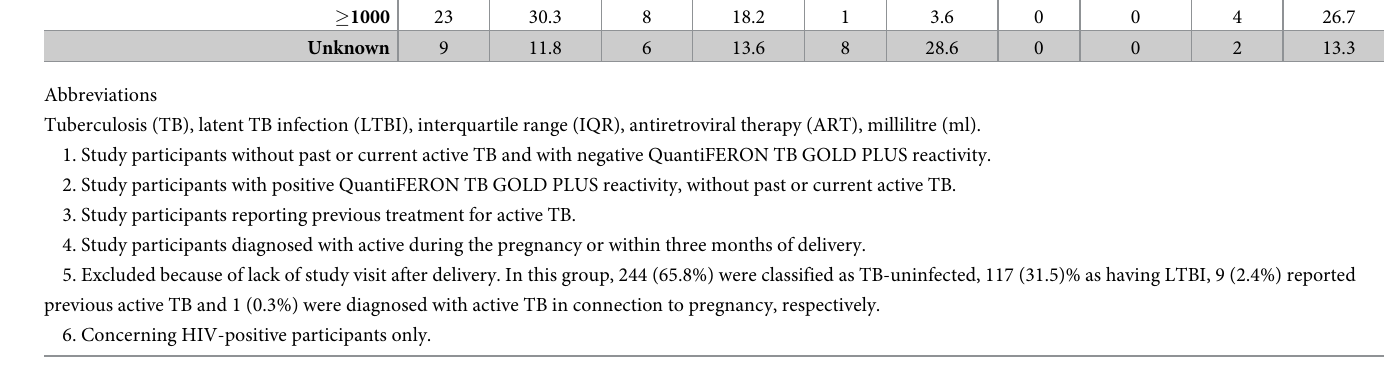
No maternal deaths were observed among the included women. In total, 64 (4.4%) preg- nancies resulted in intrauterine demise, among which 11 (17.2%) were classified as spontane- ous abortions and 47 (73.4%) as stillbirths, and 6 deaths (9.4%) occurred an at unknown gestational age (Table 2). Fifteen neonatal deaths were observed (1.0%). One-hundred-sixty- seven (11.4%) and 22 (1.5%) women delivered by caesarean section and instrumental delivery, respectively, and 110 (7.5%) were hospitalized for � 24 hours in connection to delivery. Three participants reported foetal congenital malformation, these pregnancies resulted in stillbirth. Stillbirth and neonatal death with regard to maternal LTBI Rates of spontaneous abortion (5/470, 1.1% vs 5/921, 0.5%) and stillbirth (19/470, 4.0% vs 25/921 (2.7%) were slightly higher in participants with LTBI compared to TB-uninfected participants. Stillbirth was not significantly associated with maternal LTBI in simple (OR 1.51, p = 0.18) or multivariable logistic regression analysis adjusting for HIV status, age and gravidity (AOR 1.38, 95% CI 0.73–2.57, p = 0.30) (Table 3). In sensitivity analysis with additional adjustment for mater- nal education and marital status, number of rooms and presence of electricity and latrine in the household, similar results were obtained (AOR 1.40, 95% CI 0.73–2.63, p = 0.30, S1 Table). The proportions of neonatal death (1.1% vs 1.1%) were similar among women with LTBI compared to those without TB infection. Similar findings were obtained for rates of hospitali- zation (7.7% vs 7.7%) and caesarean section (11.9% vs